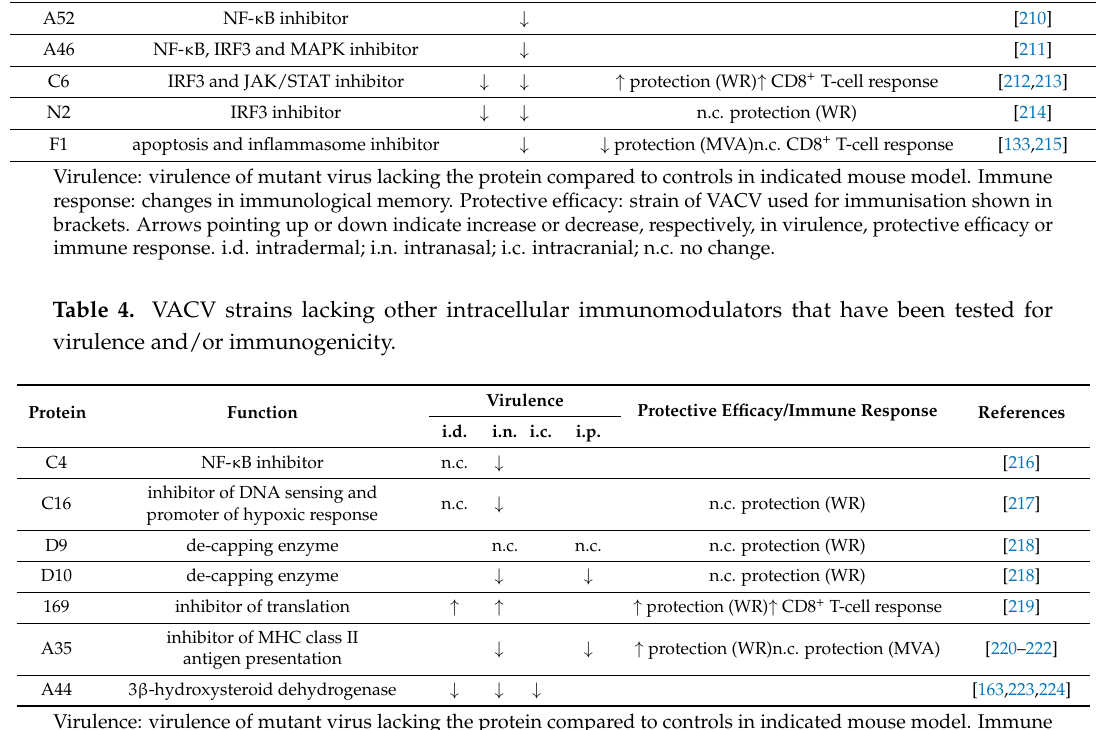
Virulence: virulence of mutant virus lacking the protein compared to controls in indicated mouse model. Immune response: changes in immunological memory. Protective efficacy: strain of VACV used for immunisation shown in brackets. Arrows pointing up or down indicate increase or decrease, respectively, in virulence, protective efficacy or immune response. i.d. intradermal; i.n. intranasal; i.c. intracranial; i.p. intraperitoneal; n.c. no